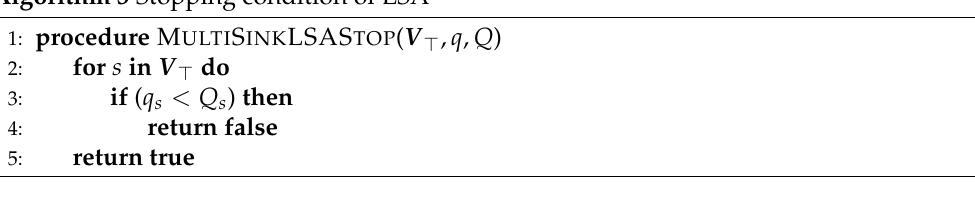
Algorithm 3 Stopping condition of LSA